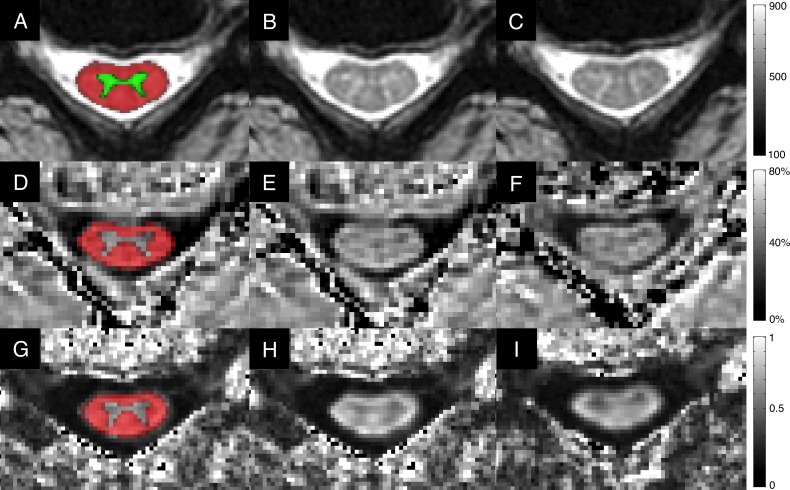
Representative images.A-C: T2*WI images showing mild spinal cord compression at C4-5, including: A) probabilistic SCT maps of GM (green) and WM (red) registered directly to anatomical images to calculate T2*WI WM/GM signal intensity ratio; B) baseline assessment; C) 13-month follow-up showing no change in the degree of spinal cord compression. Corresponding DTI FA maps (D-F) and MTR maps (G-I) are displayed demonstrating probabilistic WM maps (red, D, G); baseline assessments (E, H); and follow-up images (F, I). Visual inspection does not show obvious differences, but the quantitative readout (averaged over several slices) indicated progressive tissue injury including significant deterioration in composite score (t = -4.1), MTR of the rostral cord (z = -3.0), and T2*WI WM/GM of the rostral cord (z = -4.0). FA also showed a trend toward a decrease in the rostral cord (z = -2.3). CSA: cross-sectional area; DTI: diffusion tensor imaging; FA: fractional anisotropy; GM: grey matter; MTR: magnetization transfer ratio; T2*WI: T2*-weighted imaging; WM: white matter.